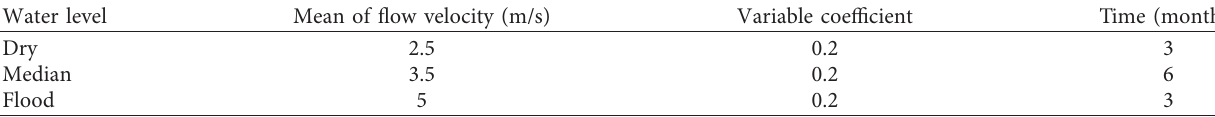
Table 3: Water flow velocity at Shabin Road in Chongqing City.